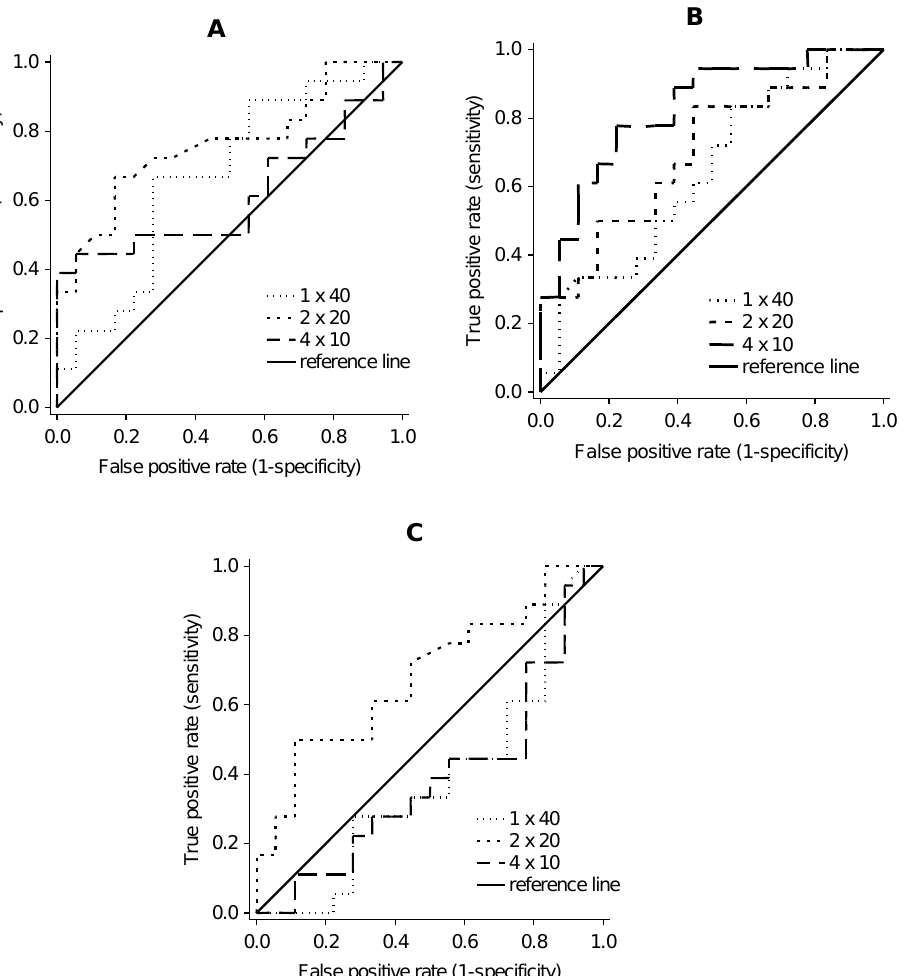
Figure 3. Receiver operating characteristic (ROC) curves for indices of Fyre-Zyme reagent impact on antivity of acid phosphatase ( A ), alkaline phosphatase ( B ), and dehydrogenases ( C ).